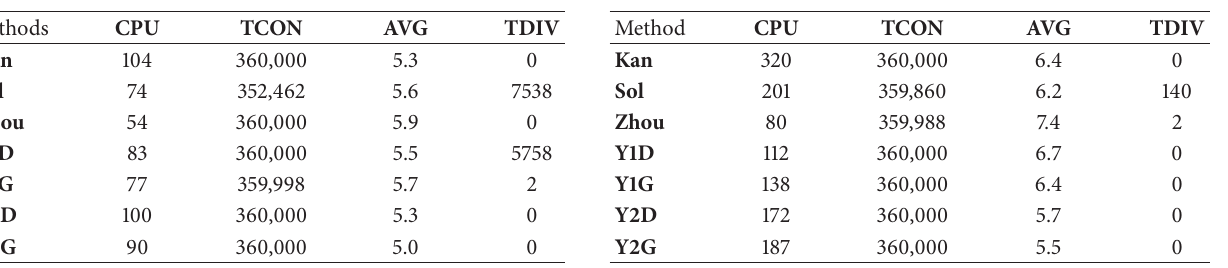
Table 6: Typical Example 3 with 𝑃 3 (𝑧) = (𝑧 3 − 𝑧) 4 , 𝑚 = 4 .